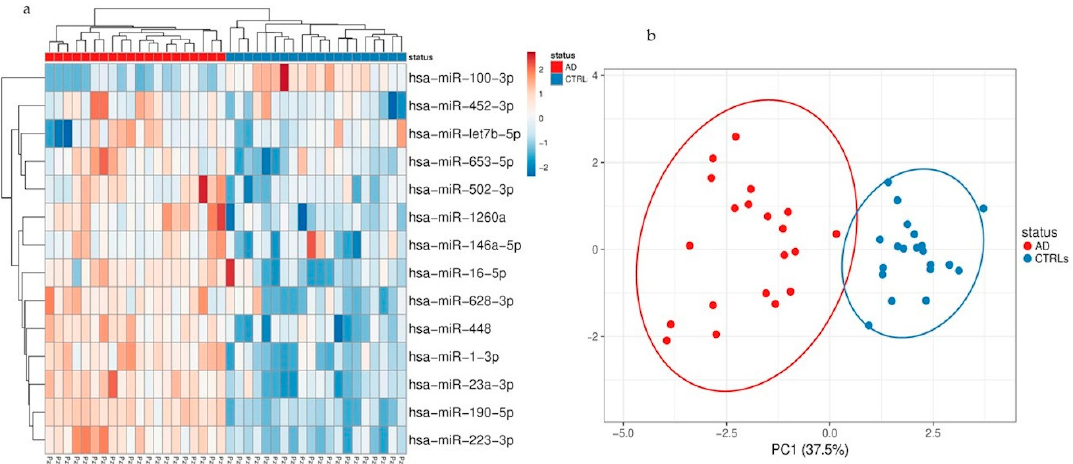
Figure 3. ( a ) Hierarchical clustering of samples based on microRNA (miRNA) profiles observed in total plasma EVs from Alzheimer’s disease (AD) patients and control subjects (CTRLs). The most variant (according to the coefficient of variation) miRNAs were used for clustering analysis (Pearson correlation, average linkage). Rows are centered and unit variance scaling is applied to normalized expression values. Color indicates relative up- (red) or downregulation for each miRNA (row). ( b ) Principle component analysis based on the most variant miRNAs in total plasma EVs.